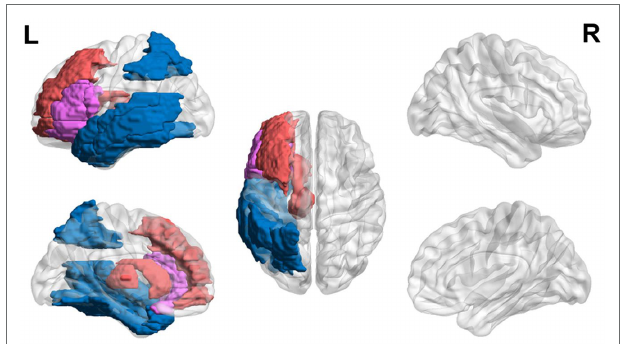
FIGURE 3 | Neural circuit dysfunction related to reading circuits in teenagers (ages 13–21) with dyslexia. Decreased activation in the left inferior frontal gyrus (Wimmer et al., 2010; Steinbrink et al., 2012), left parietal lobule (Hoeft et al., 2007; Wimmer et al., 2010; Steinbrink et al., 2012), left fusiform gyrus (Hoeft et al., 2007; Desroches et al., 2010), and left temporal gyrus (Wimmer et al., 2010; Steinbrink et al., 2012) and increased activation in the left inferior frontal gyrus (Hoeft et al., 2007), left middle frontal gyrus (Hoeft et al., 2007), left caudate (Hoeft et al., 2007), and left thalamus (Hoeft et al., 2007) related to EF in children ages 13–21 at risk for dyslexia. Red represents areas of hyperactivity, blue areas of hypoactivity, and purple areas where papers have reported hyperactivity and hypoactivity. Data are presented in sagittal and axial views in the left and right hemispheres (L = left and R = right) over a glass brain. Regions were defined based on AAL atlas (Tzourio-Mazoyer et al., 2002). Image created using the BrainNet Viewer (Xia et al., 2013).